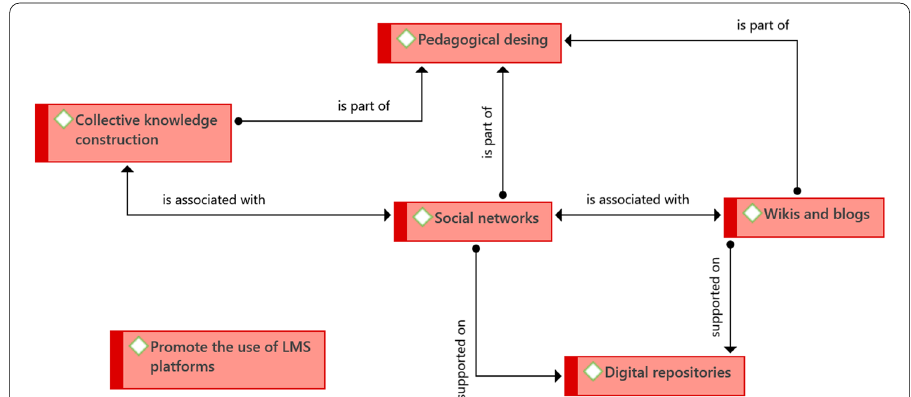
Fig. 5 Structure of driving ideas associated with what they do in technology. Source: Diógenes